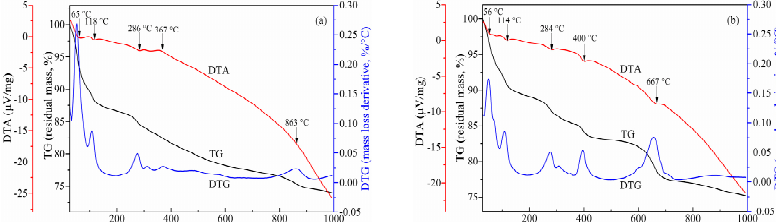
Figure 7. TG-DTA curves for solidified bodies ( a )-CFBCFA based solidified bodies; ( b )-cement based solidified bodies.